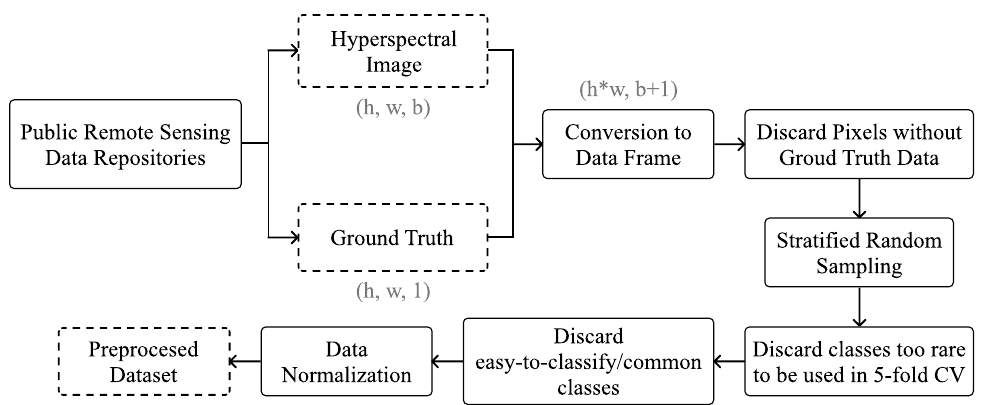
Figure 4. Data collection and preprocessing